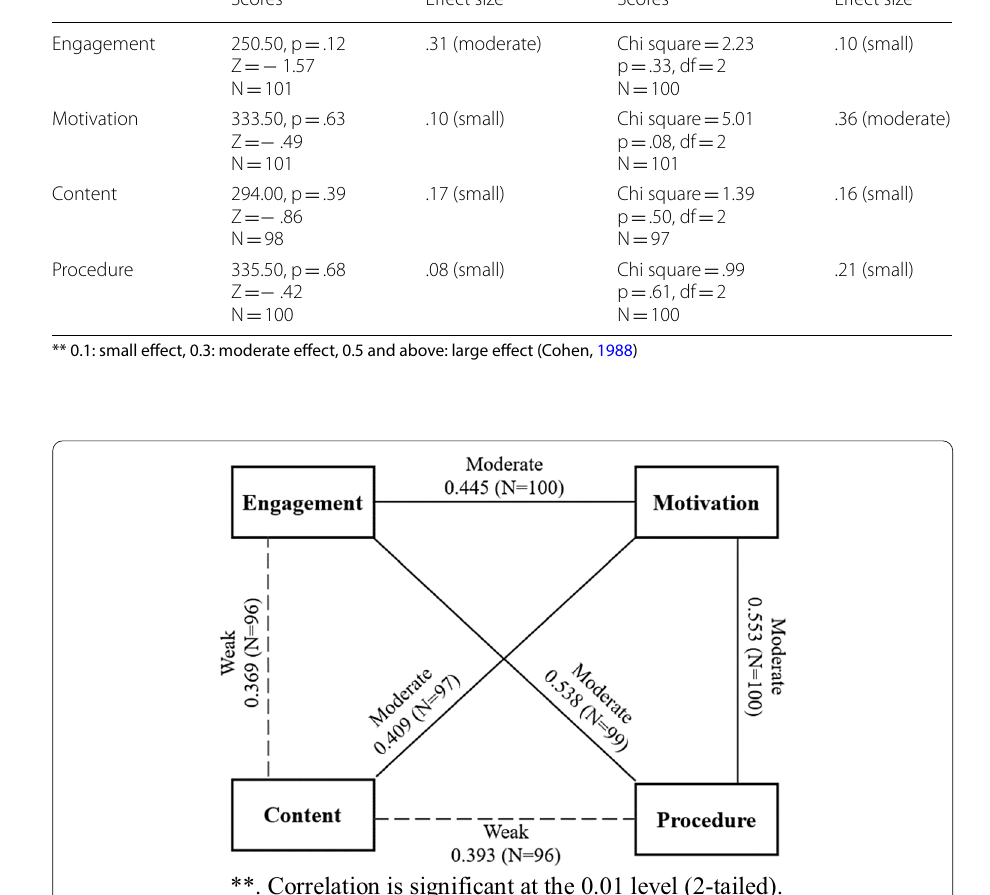
Fig. 2 Correlation between pedagogical